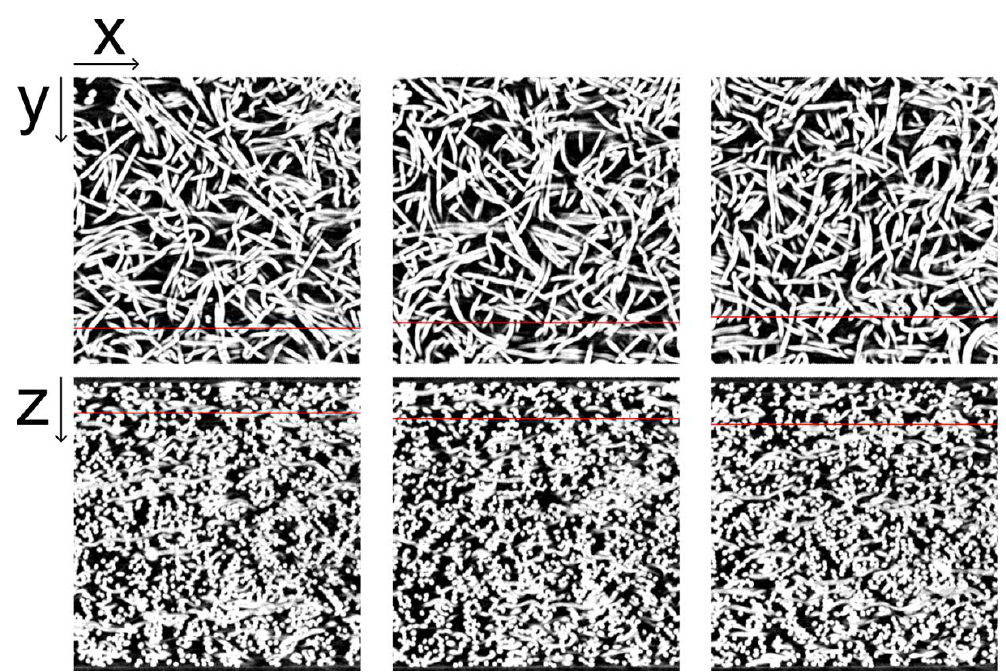
Figure 8. Cross-sectional X-ray computed tomography images of 12-ply laminated product. The upper images are the xy-plane images cut by the red lines in the lower images. The lower images are the xz-plane images cut by red lines in the upper images. The left, center, and right cut positions are all shifted by 10 μm.